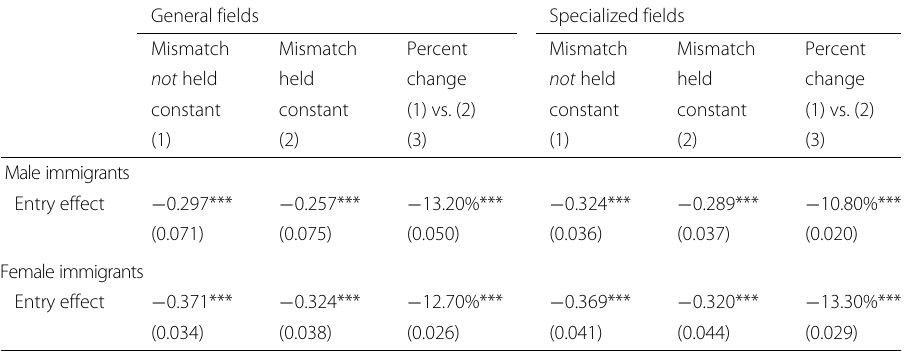
Table 9 Percent of entry effect due to mismatch: general vs. specialized fields (non-traditional